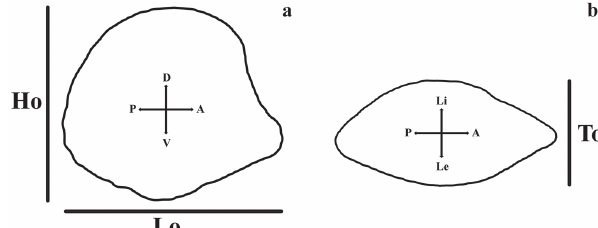
Fig. 2. Schematic representation of Genidens genidens otolith measurements: maximum length (Lo), maximum height (Ho) and maximum thickness (To). a. Lateral view; b. lateroventral view. Structures: dorsal (D), ventral (V), posterior (P), anterior (A), internal lateral face (Li) and external lateral face (Le) position relative to the